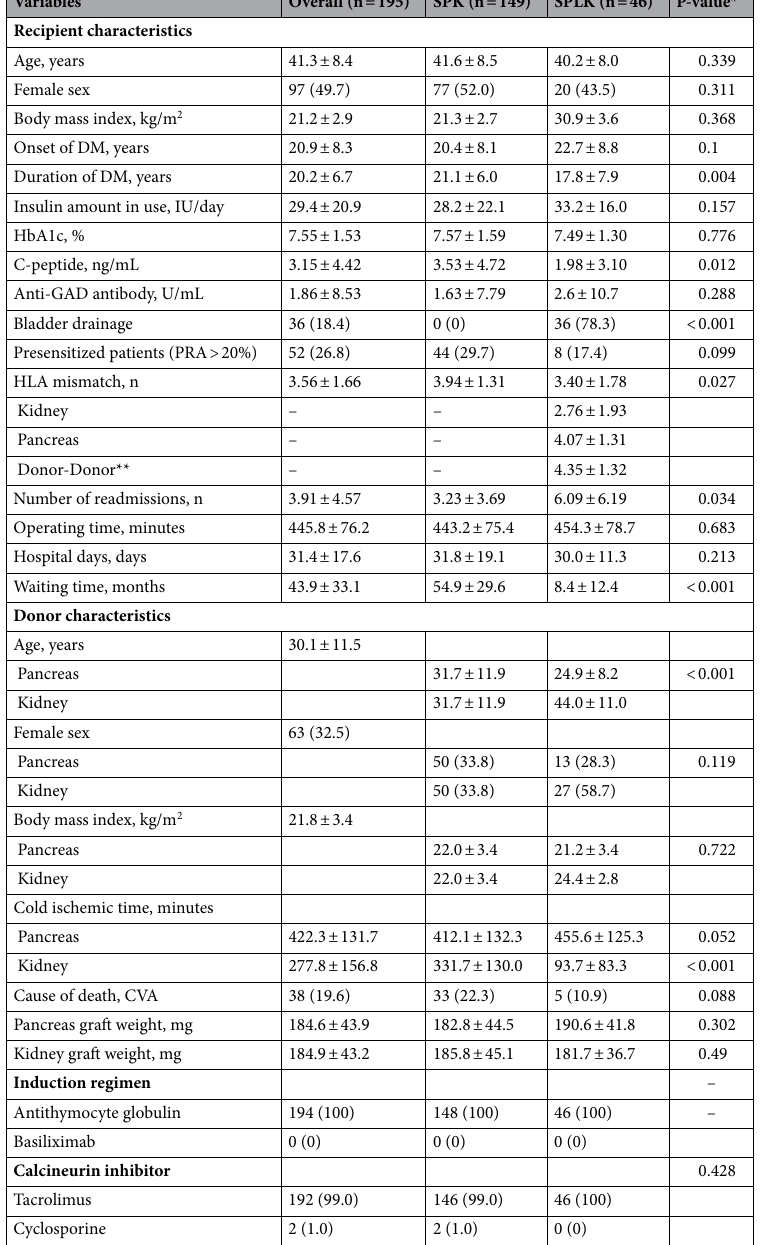
Table 1. Recipient and donor demographic data and baseline characteristics for SPK and SPLK groups in the study. SPK simultaneous pancreas-kidney transplant, SPLK simultaneous deceased donor pancreas and living donor kidney transplant, DM diabetes mellitus, HLA human leukocyte antigen, CVA cerebrovascular accident. *SPK vs. SPLK/Data are mean ± standard deviation or n (%). **Counted HLA antigens present on living kidney donor but not on the deceased pancreas